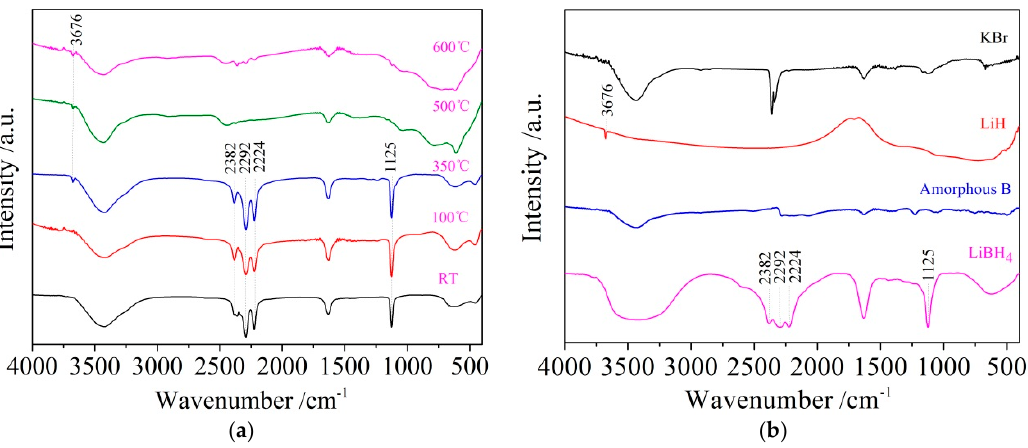
Figure 5. Fourier transform infrared spectroscopy (FTIR) patterns of the LiBH 4 /Al* sample ( a ) obtained at different temperatures (room temperature, 100, 350, 500, and 600 °C) and reference substances ( b ) including KBr, LiH, amorphous B, and LiBH 4 .